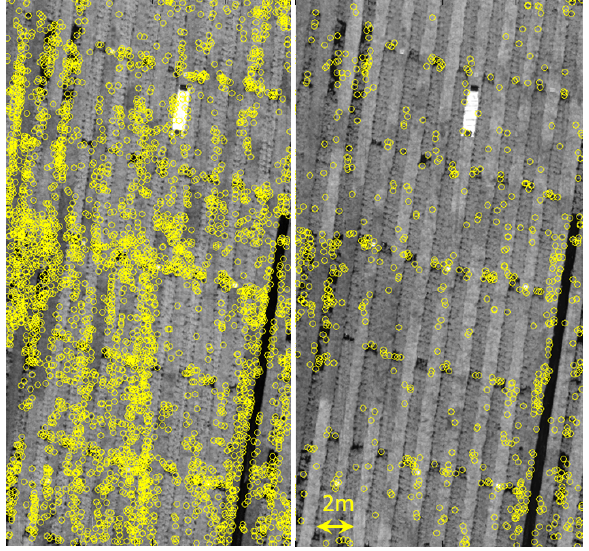
Figure 14. SIFT matching results after false matches elimination for reference band 31 (736.8nm) matched with band 33 (604.0nm, left, 3742 points) and with band 70 (888.5nm, right, 749